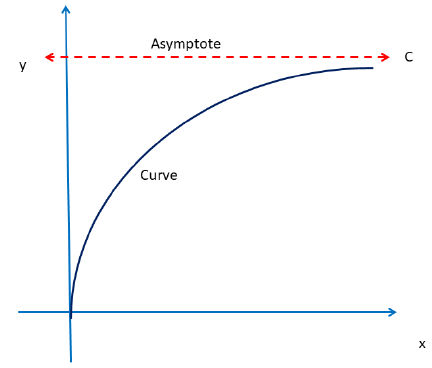
Figure 3. Horizontal asymptote as in the source: